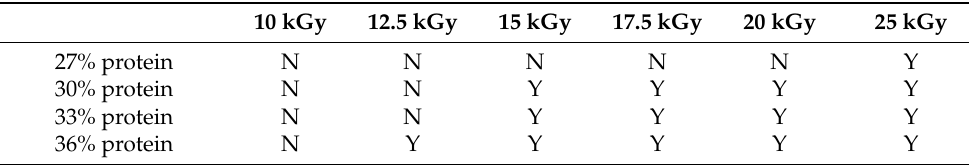
Table 2. The observation of sample gelation during six months after